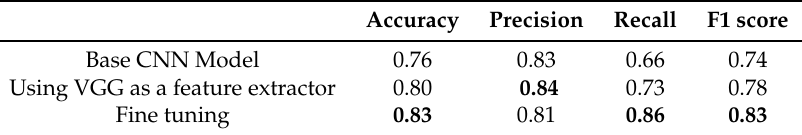
Table 2. Resulting metrics.